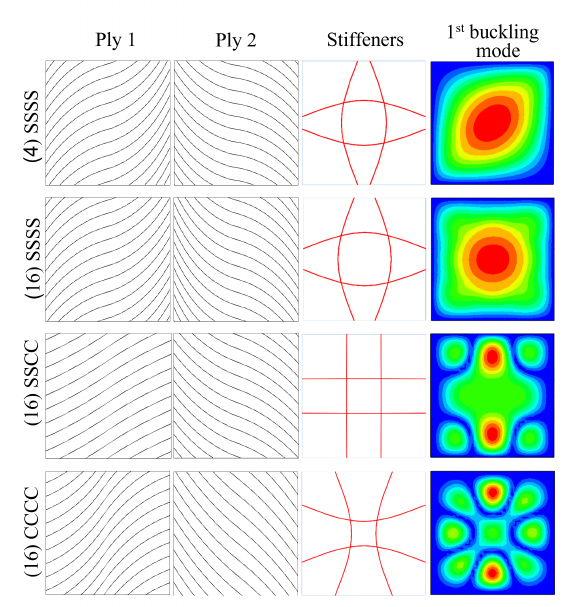
Figure 13. Optimized panels considering gap effect, subjected to biaxial compression.